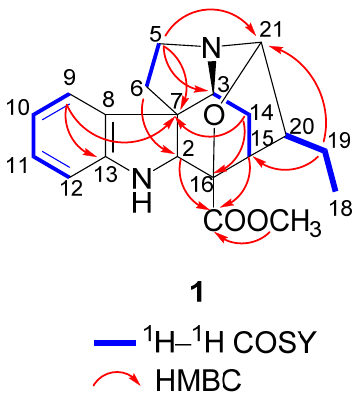
Figure 2. Key 1 H − 1 H COSY and HMBC correlations of 1 . Figure 2. Key 1 H– 1 H COSY and HMBC correlations of 1 . The 2D structure of compound 1 determined by the NOESY cross-peaks (Figure 3) The 2D structure of compound 1 determined by the NOESY cross-peaks (Figure 3) between H-9 and H-3/H-6 α , between H-14 α and H-3/H-15, and between H-20 between H-9 and H-3/H-6 α , between H-14 α and H-3/H-15, and between H-20 and H- 15/H-21 indicated the same orientation of these protons. The NOESY cross-peaks between H-6 β and H-2 indicated that H-2 was β -oriented. The absolute configuration of 1 was iden- tified by CD experiment (Figure 4), and the negative Cotton effect at λ max 275 ( − 2.8) nm and the positive Cotton effects at λ max 245 ( + 11.7) nm and 210 ( + 11.2) nm in CD spectrum were consistent with the calculated configuration of (2 R , 3 S , 7 S , 15 S , 16 R , 20 S , 21 S )- 1 . Con- sequently, compound 1 was identified and named as gardflorine A.